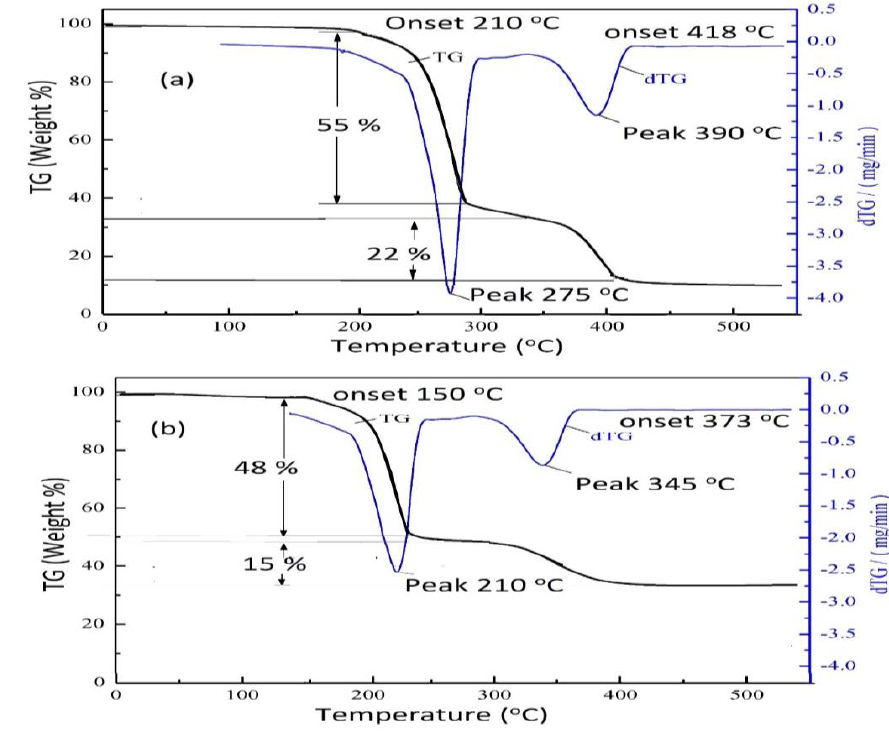
Figure 6. TGA-DTG thermograms of ( a ) APA and ( b ) PAIIL.